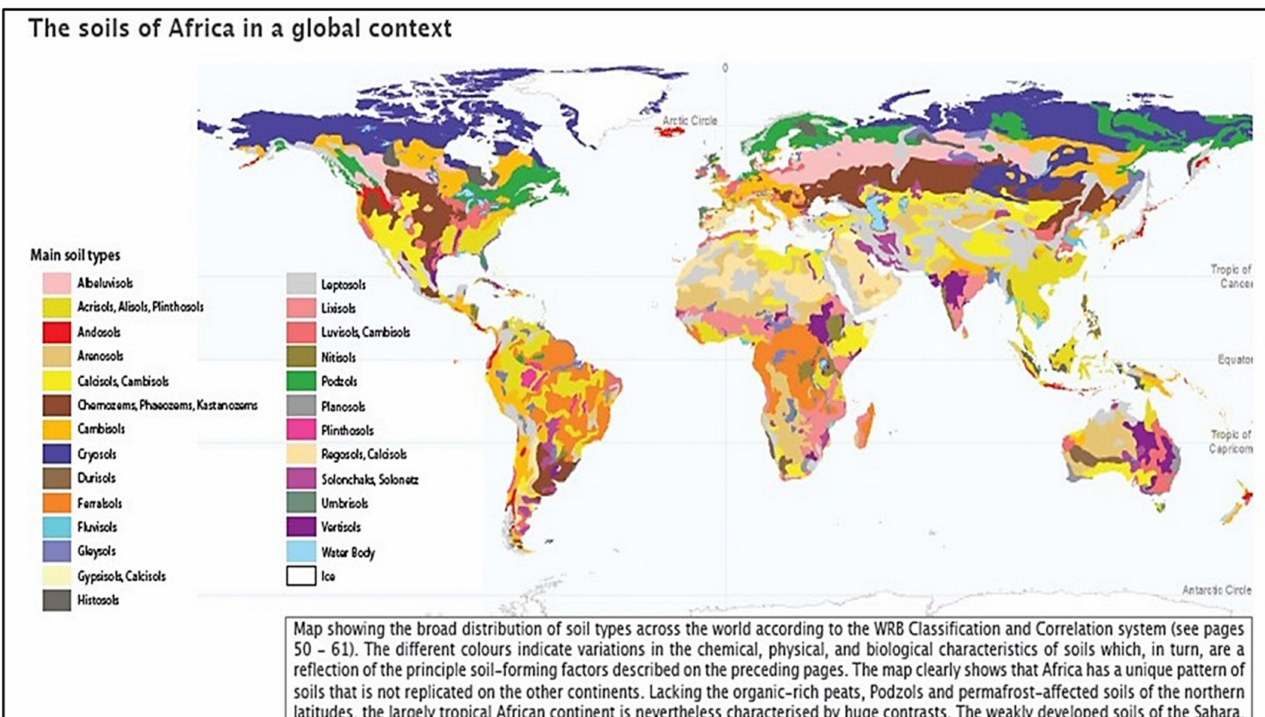
Figure 5. Ref. [32]: Distribution of surface material characteristics (soils) of the African continent in the global context with specific emphasis on the distribution of non-Silicate materials, such a Calcisols and Camisoles.